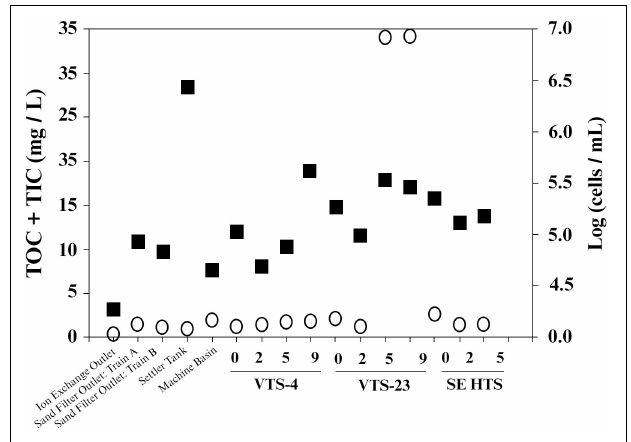
FIGURE 2 | Carbon [total organic carbon (TOC) + total inorganic carbon (TIC); open circle, O] and bacterial cell density [log transformed (cells/mL); closed square, (cid:4) ] measured from basin water collected from operational/mechanical units that service the storage basin proper, as well as three distinct spent nuclear fuel storage locations (VTS-4, VTS-23, and SE HTS) at depth